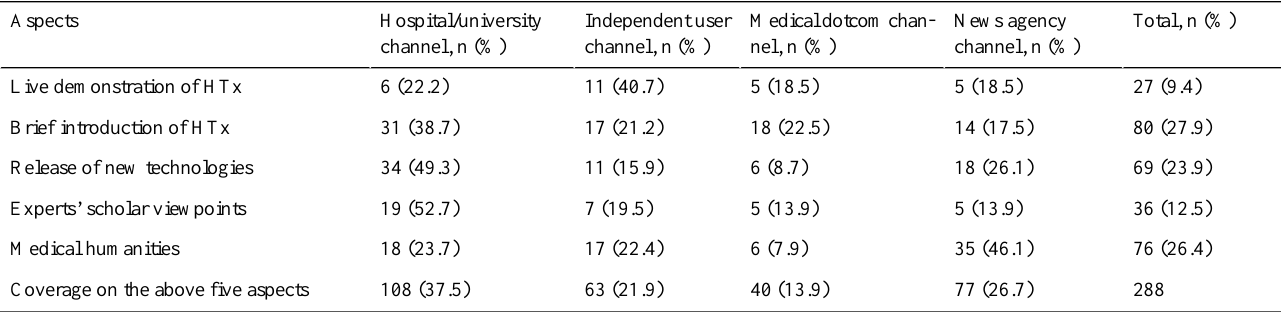
Table 4. Detailed content analysis of “useful videos” from five aspects.